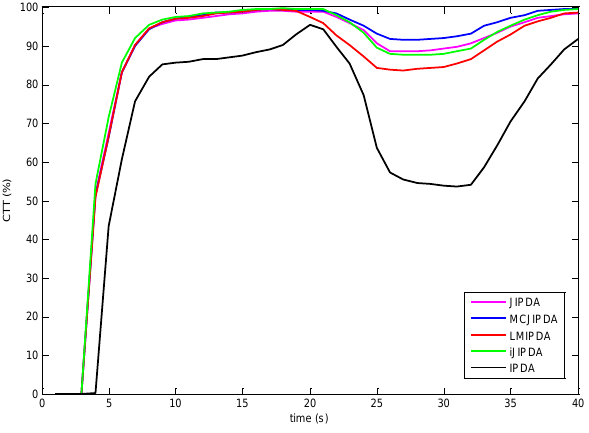
Figure 6. The confirmed true tracks rate for Case #1.